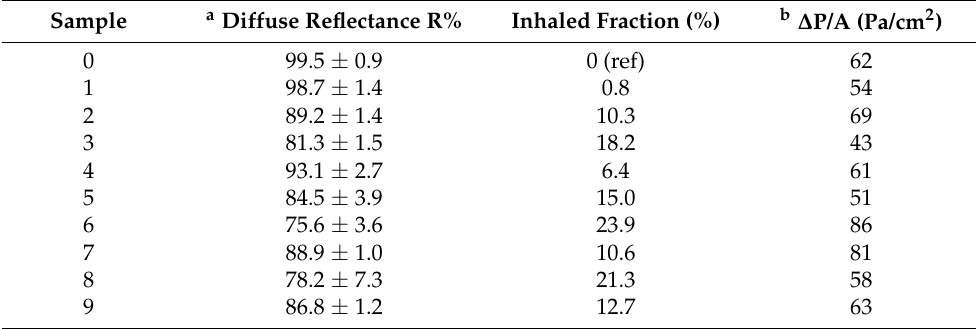
Table 2. Diffuse reflectance values measured after 30 min of MB nebulization; calculated percentage inhaled fraction, and breathability values for the set of investigated face masks. Sample a Diffuse Reflectance R% Inhaled Fraction (%) b ∆ P/A (Pa/cm 2 ) 0 99.5 ± 0.9 0